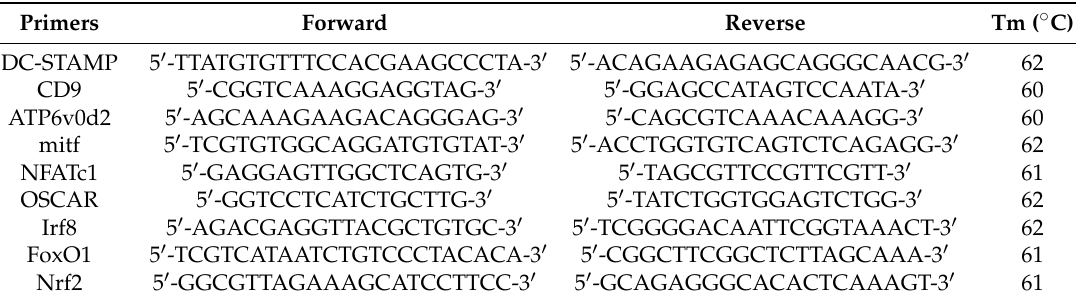
Table 1. Primer sequences for